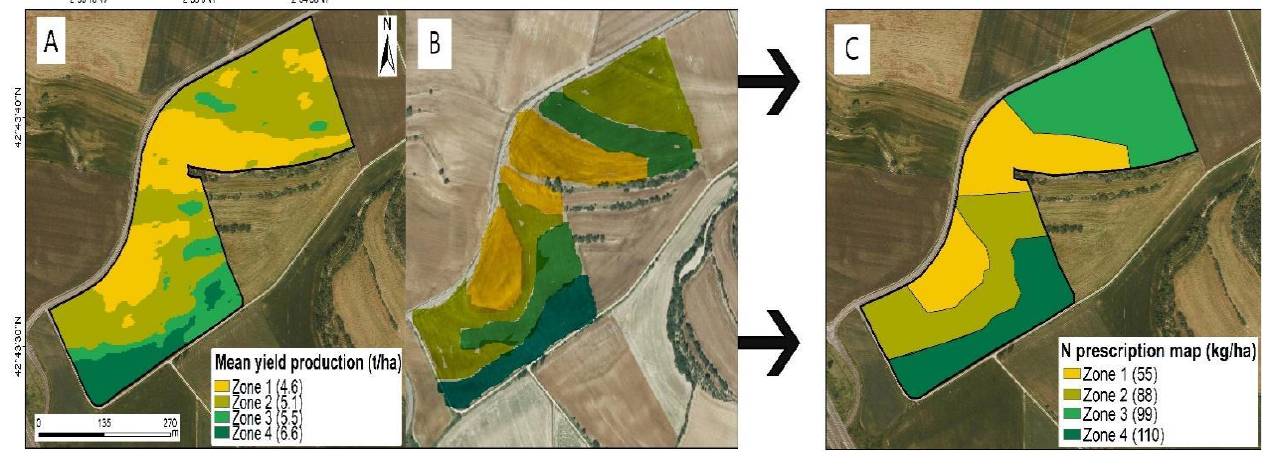
Figure 5. ( A ) Interpolated map based on the estimated yield data according to the RF algorithm. ( B ) Yield map provided by the farmer. ( C ) Nitrogen fertilizer prescription map derived from maps ( A , B ). Afterwards, to verify whether there were differences in production between the zones, an ANOVA, and subsequent post hoc HSD Tukey test were conducted. The analysis showed that there were significant differences ( p < 0.001) in production between the four zones ( A